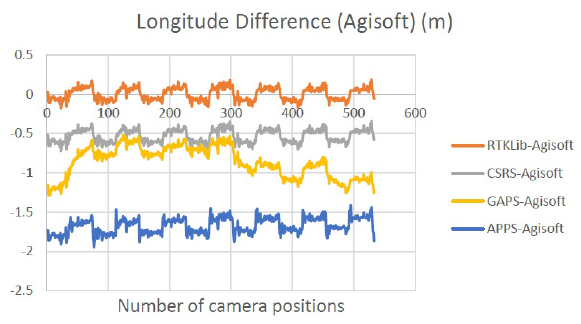
Fig. 9. Longitude differences between the coordinates produced by Agisoft Metashape and the software utilized in this project.